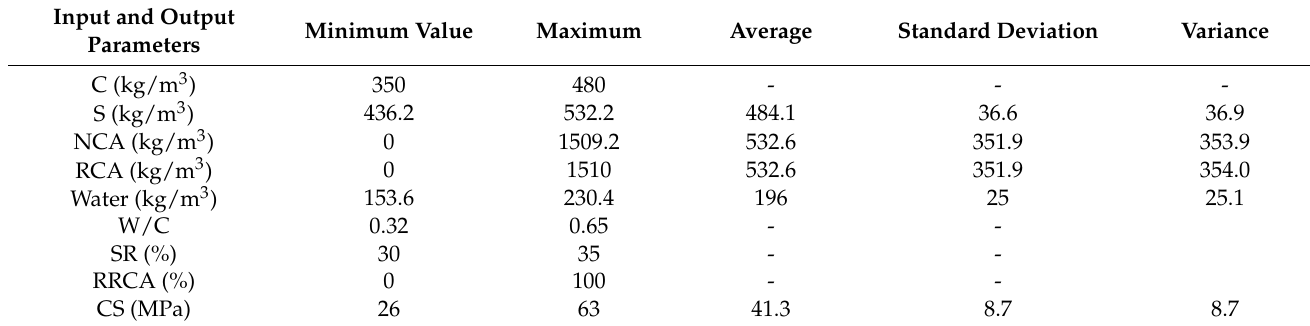
Table 6. Numerical value statistics of experimental parameters.